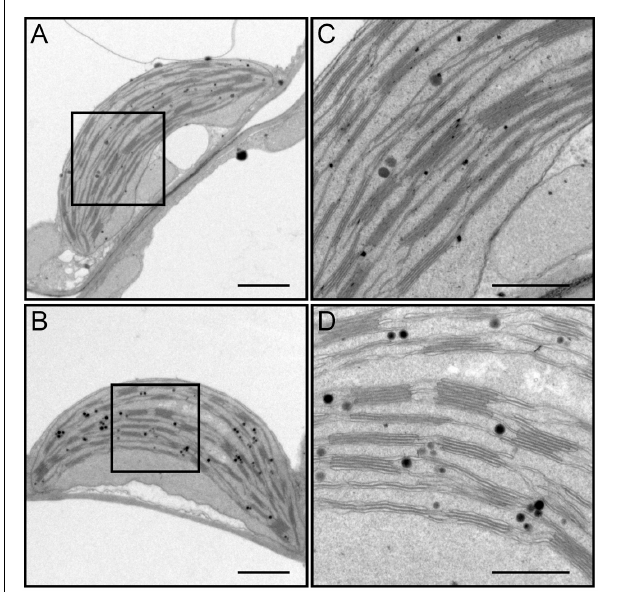
FIGURE 6 | Transmission electron microscopy (TEM) observation of chloroplasts from leaves of the wild-type (WT) (A,C) and the dy1 mutant seedlings (B,D) . Bars = 1 µ m (in A,B ) or 500 nm (in C,D ). (C,D) Are magnified views of the boxed regions in (A,B) ,